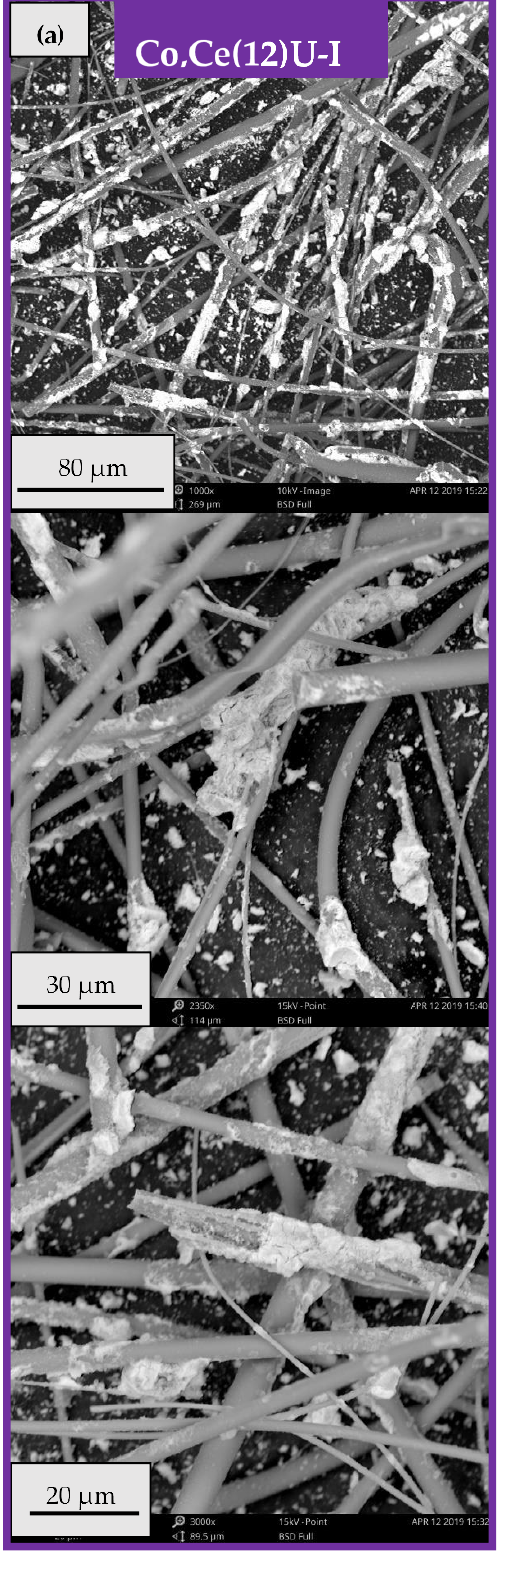
Figure 11. SEM micrographs of the samples with 12% active phase: ( a ) Co,Ce(12)U-I and ( b ) Co,Ba,K(12)U-I.